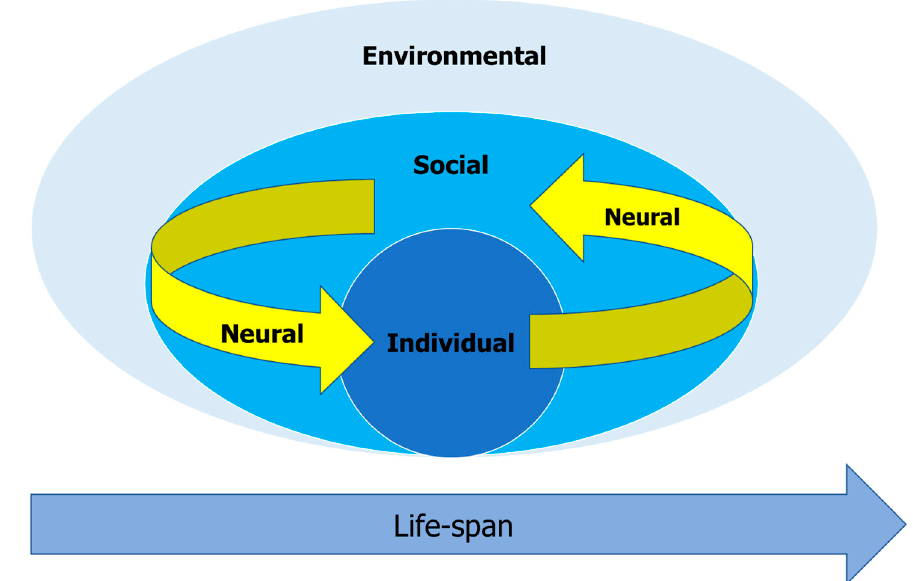
Figure 1. Multi-domain digital neurophenotyping model for sensor-based data collection, analysis, and integration using individual, social, neural, environmental, and life-span domains.